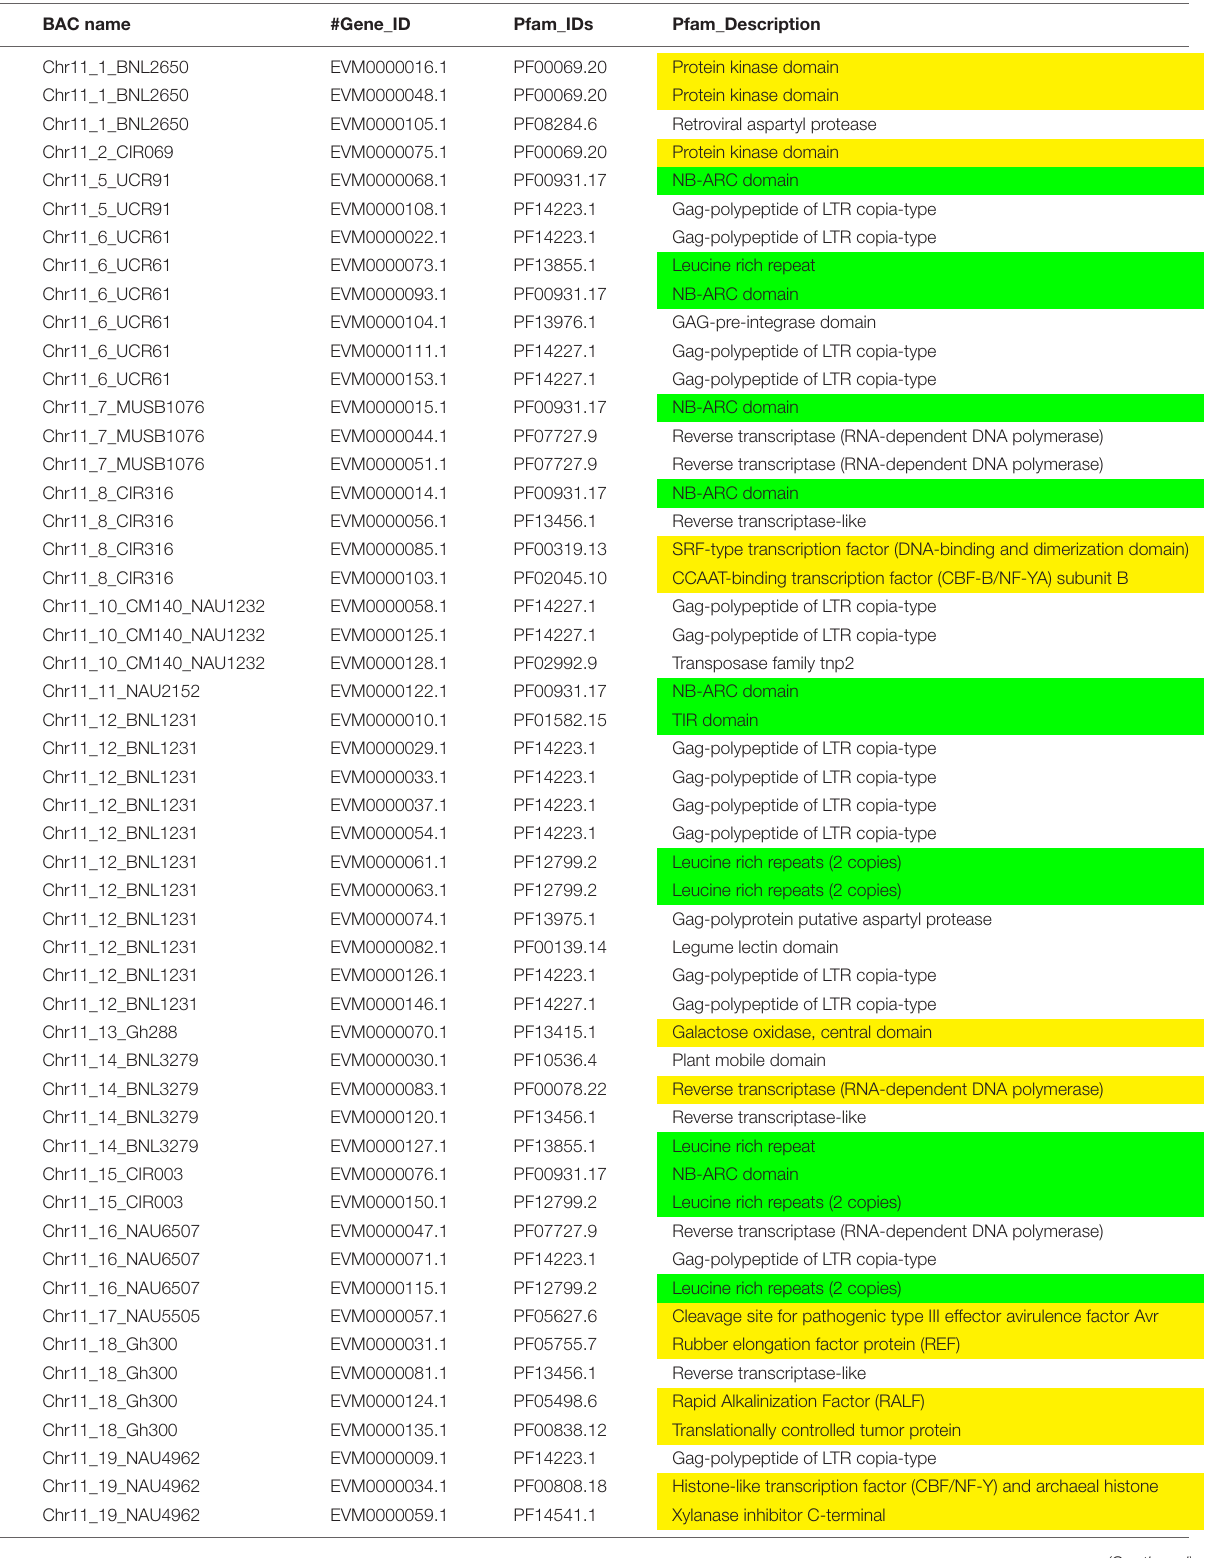
TABLE 3 | The Pfam (Protein family, http://pfam.xfam.org/) gene annotation of Chr 11 BACs with a similar e value cutoff ≤